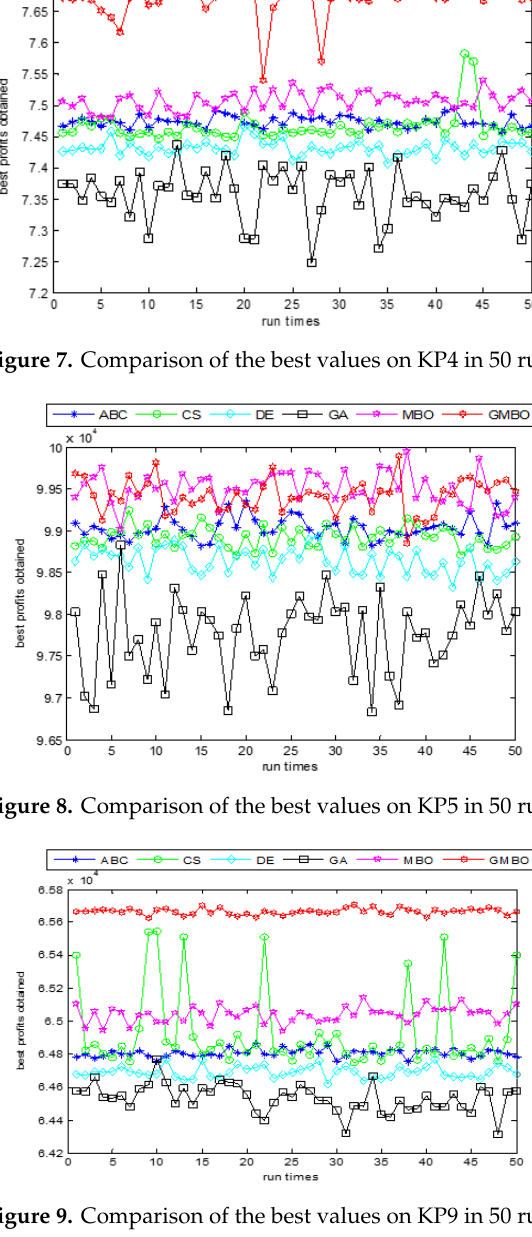
Figure 8. Comparison of the best values on KP5 in 50 runs.